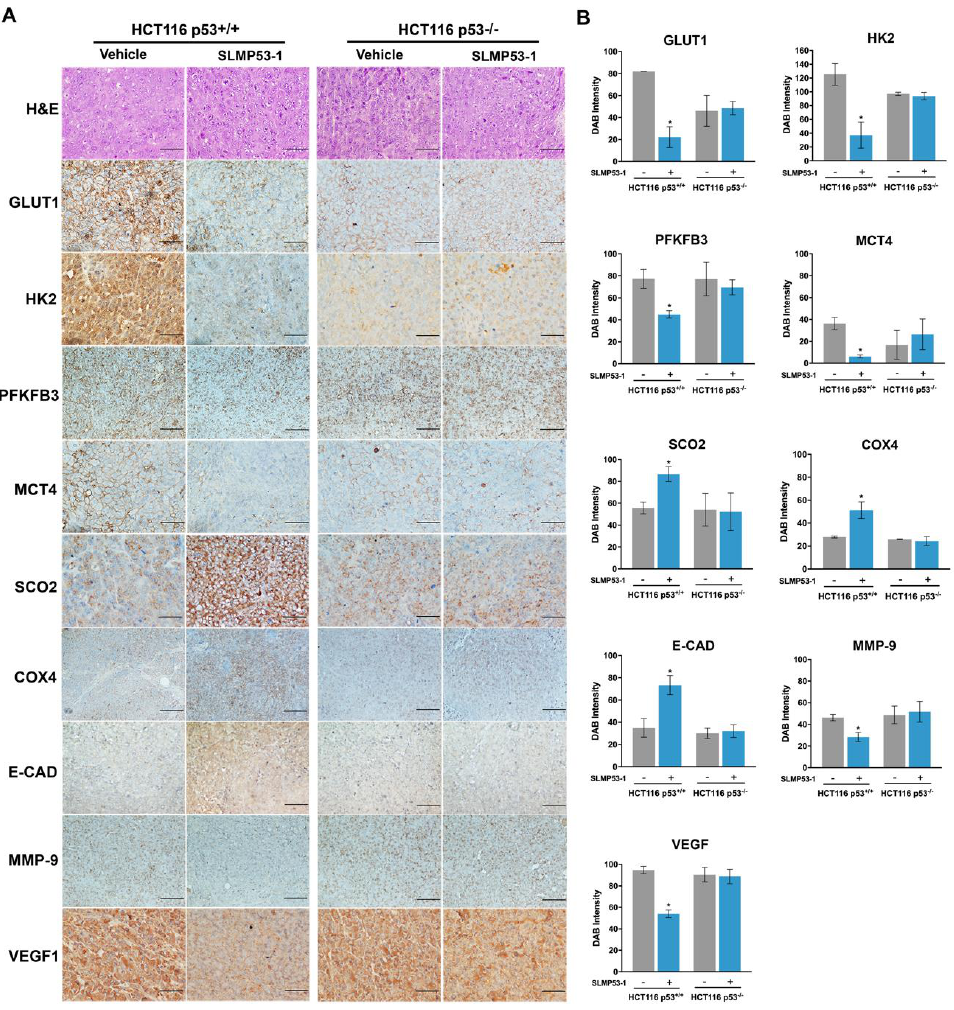
Figure 2. SLMP53-1 modulates the Warburg effect and angiogenesis, interfering with ECM remodeling and EMT events, through a p53-dependent pathway, in tumor tissues of xenograft mouse models. ( A , B ) Detection of molecular markers involved in glycolysis, OXPHOS, angiogenesis, and migration, in tumor tissues of p53 +/+ and p53 −/− HCT116 xenografts treated with 50 mg/kg SLMP53-1 or vehicle (intraperitoneal injection twice a week, for a total of five administration [24]); in ( A ) representative images of IHC are shown; scale bar =20 μm; magnification = ×200; hematoxylin and eosin (H&E); in ( B ) quantification of IHC staining in tumor tissues of p53 +/+ and p53 −/− HCT116 xenografts treated with SLMP53-1 (+) or vehicle (−). Staining quantification was assessed by evaluation of DAB (3,3′-diaminobenzidine) intensity. Data are mean ± SEM, values significantly different from vehicle (* p < 0.05, unpaired Student’s t -test). In the same tumor tissue, the expression levels of markers associated with angiogenesis (VEGF1) and migration (MMP-9 and E-CAD) were also evaluated. When compared to vehicle, SLMP53-1 treatment decreased the expression levels of MMP-9 and VEGF1, while increasing the levels of E- CAD in p53 +/+ , but not in p53 −/− , HCT116 tumors (Figure 2A,B). Collectively, likewise in vitro, SLMP53-1 displayed the in vivo potential to antagonize the Warburg effect, also inhibiting angiogenesis and modulating key signatures of ECM remodeling and EMT processes, in vivo in a p53-dependent manner.